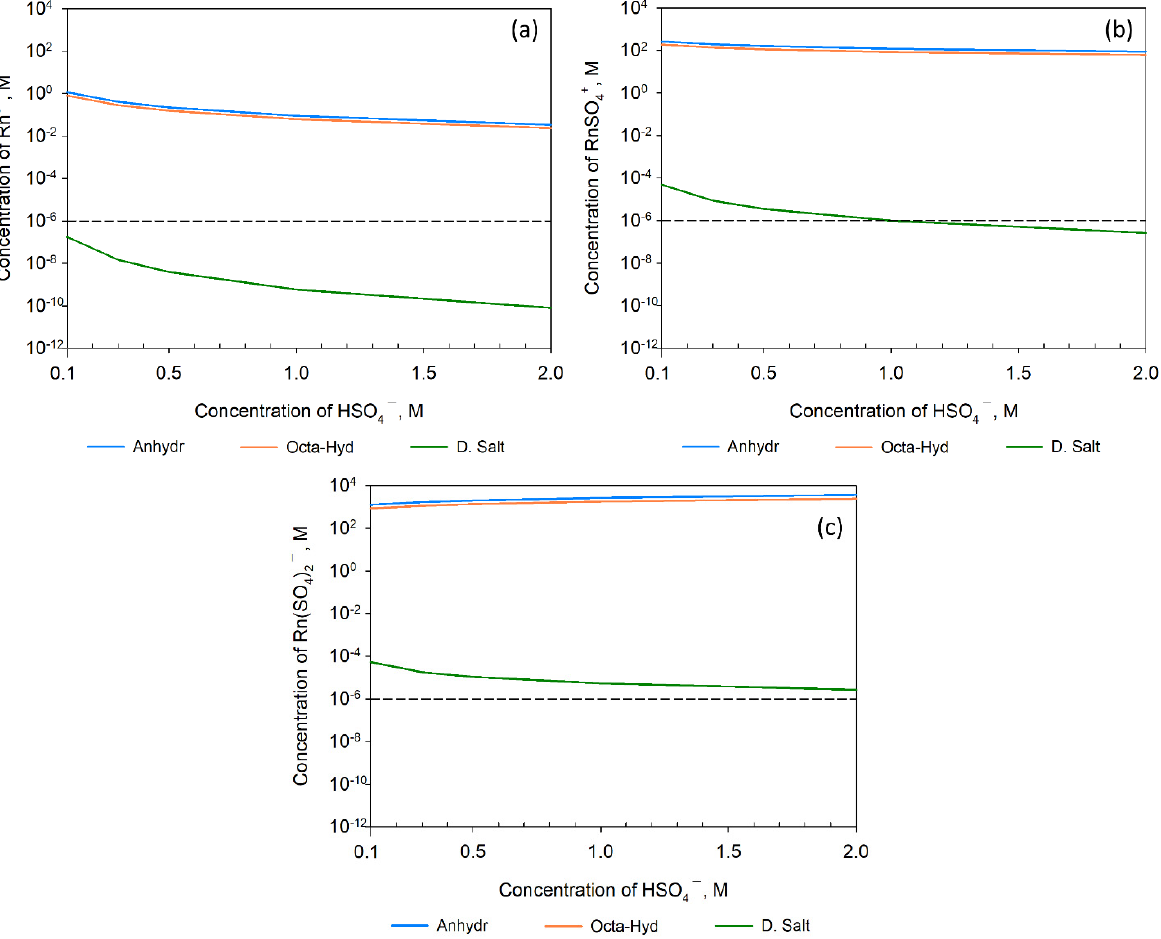
Figure 10. Graphical presentation of precipitation of Rn 3+ , Rn(SO 4 ) + , and Rn(SO 4 ) 2 − into three sulfates, anhydrous, octa-hydrated, and sodium double salt at pH 1 with H 2 SO 4 . ( a ) Rn 3+ precipitates into the three products. ( b ) Rn(SO 4 ) + precipitates into the three products. ( c ) Rn(SO 4 ) 2 − precipitates into the three products.